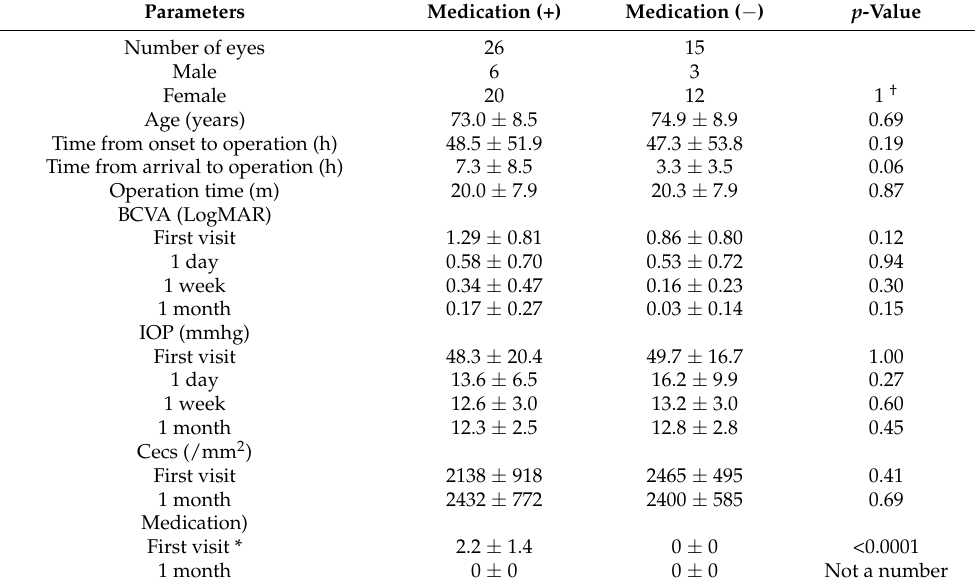
Table 2. Summary of subgroup